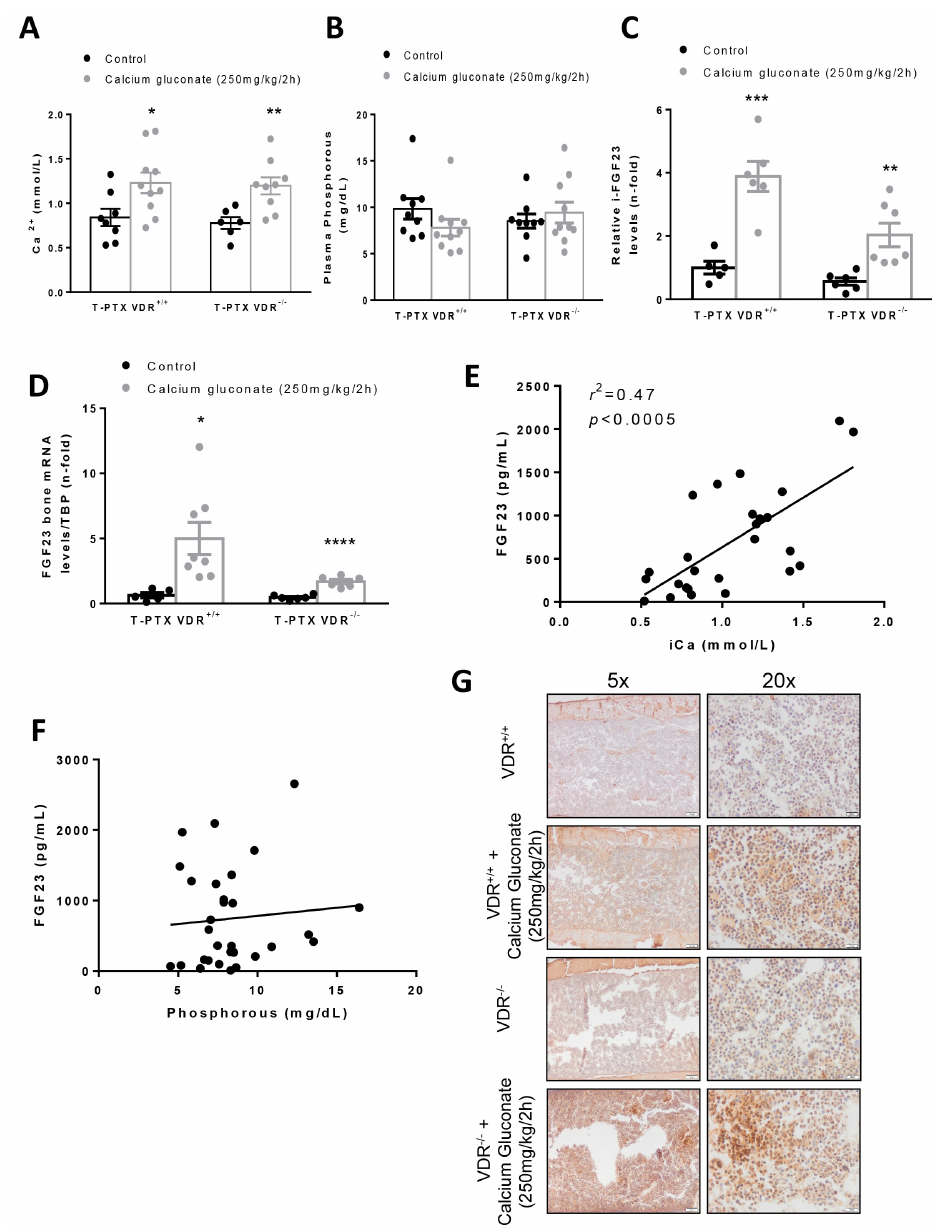
Figure 5. Experimental hypercalcemia in thyro-parathyroidectomized (T-PTX) VDR + / + and VDR − / − mice with constant levels of PTH modulates FGF23 levels. To evaluate the role of Ca 2+ in the FGF23 synthesis without influence of PTH levels, we established a model of thyro-parathyroidectomy (T- PTX) VDR +/+ and VDR − / − mice with subcutaneous implantation of osmotic minipumps filled with human PTH (1–34) (0.25 µ L/h). After that, the animals were injected or not with calcium gluconate (250 mg/kg/2h; n = 10 mice per group) for 8 h. ( A ) Plasma Ca 2+ levels in animals submitted to experimental hypercalcemia independent of PTH and VDR. ( B ) Total phosphorus plasma levels in T-PTX VDR +/+ and VDR − / − with or without calcium gluconate injection. ( C ) Intact FGF23 plasma levels of T-PTX VDR +/+ and VDR − / − mice injected with calcium gluconate. ( D ) Bone FGF23 gene expression assessed by RT-PCR. ( E ) Correlation of FGF23/Ca 2+ in T-PTX VDR +/+ and VDR − / −